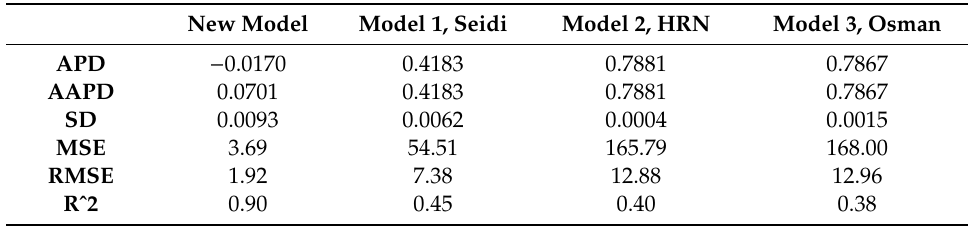
Table 6. A comparison of six di ff erent measures of accuracy corresponding to di ff erent models using the production data set of the 24 / 64 inch choke size.